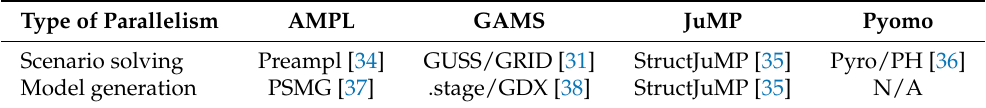
Table 4. Support for parallel scenario solving and parallel model generation in AMPL, GAMS, Pyomo, and